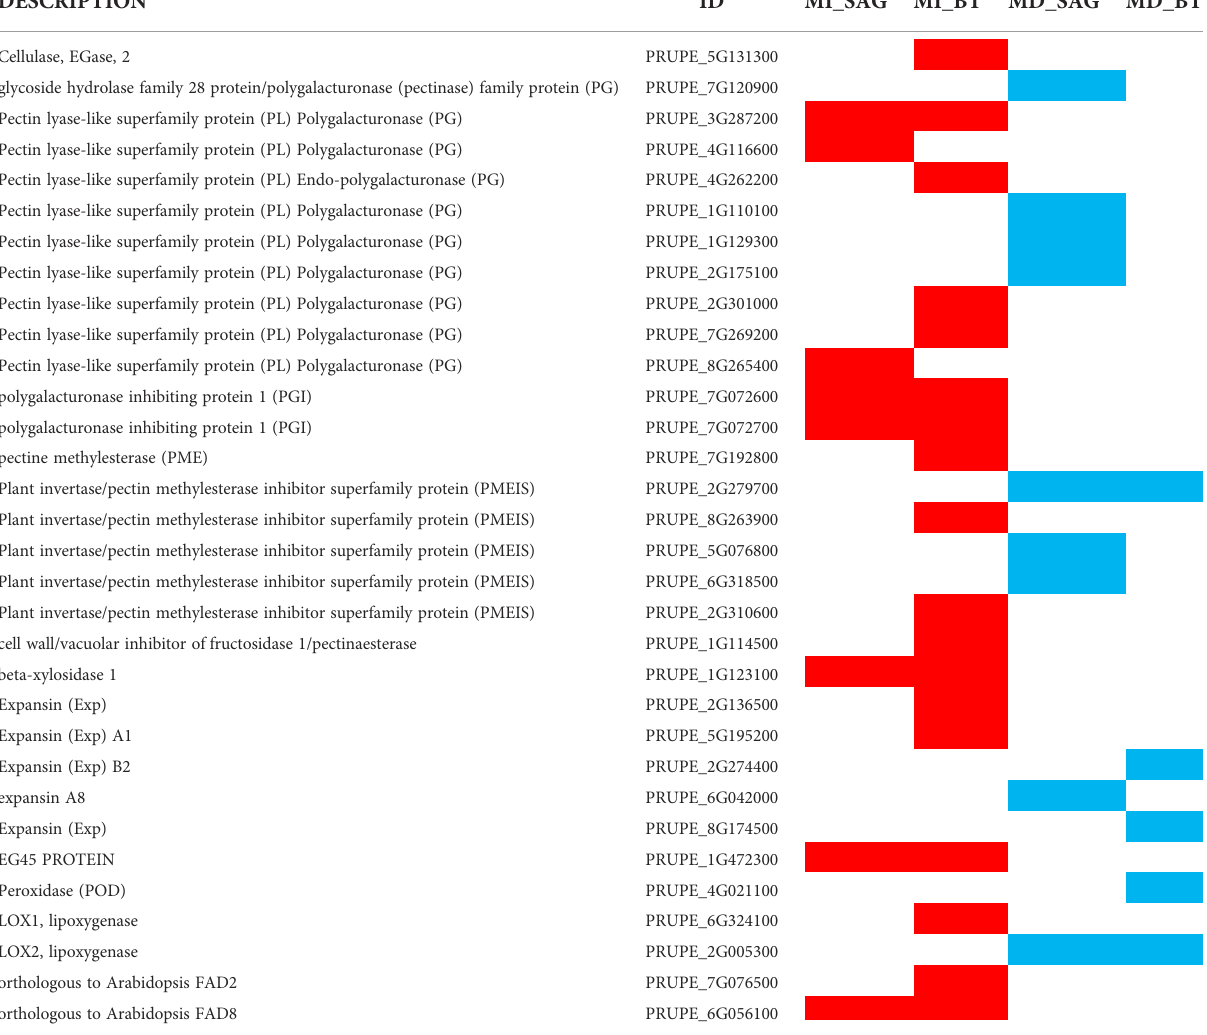
TABLE 3 Expression of monotone genes involved in the cell wall metabolism and membrane structure.